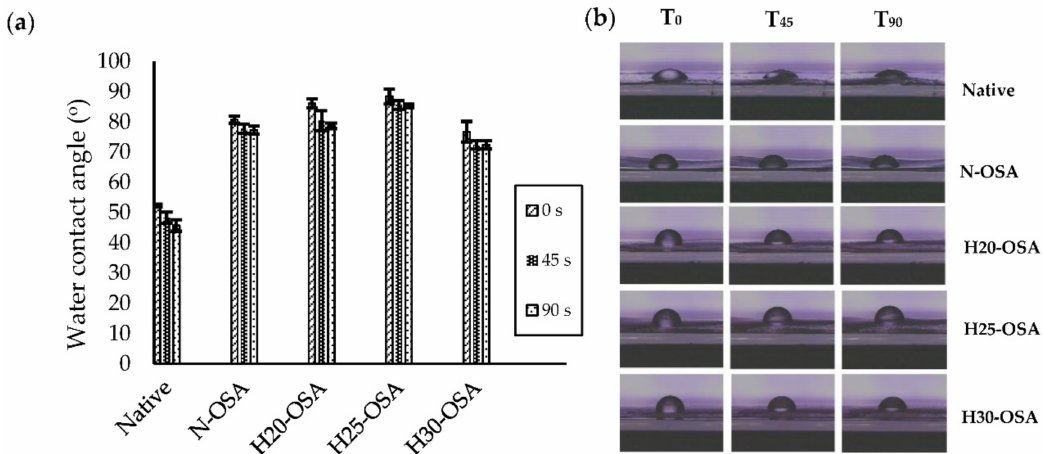
Figure 6. A plot of water contact angle values of native and modified sago starches at varied times ( a ) and contact angle images of native and modified sago starches as a function of time ( b ). N-OSA: native sago starch-OSA modification; H20-OSA: HMT 20-OSA modification; H25-OSA: HMT 25-OSA modification; H30-OSA: HMT 30-OSA modification; T 0 , T 45 , T 90 represent water contact angles of treated starch samples for 0 s, 45 s, and 90 s,